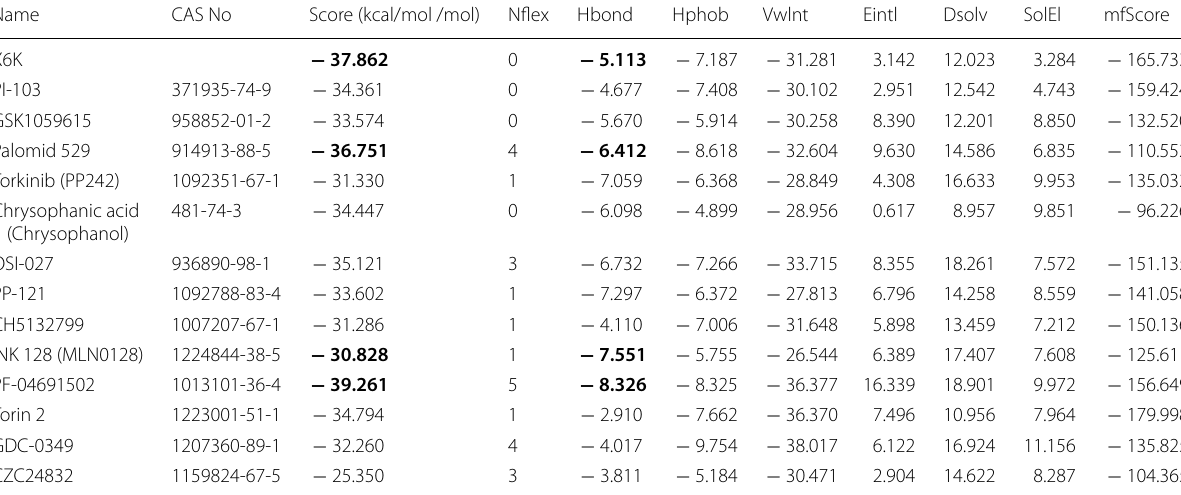
Bold values indicate the location of the most active ligand under study